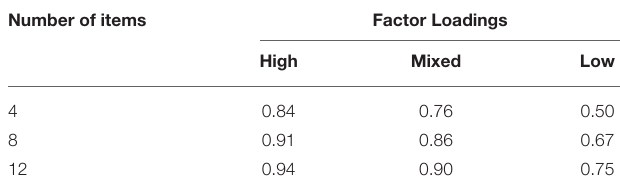
TABLE 5 | Scale reliabilities, ω , of the unidimensional skills considered in the simulation study for different number of items and the strength of the factor